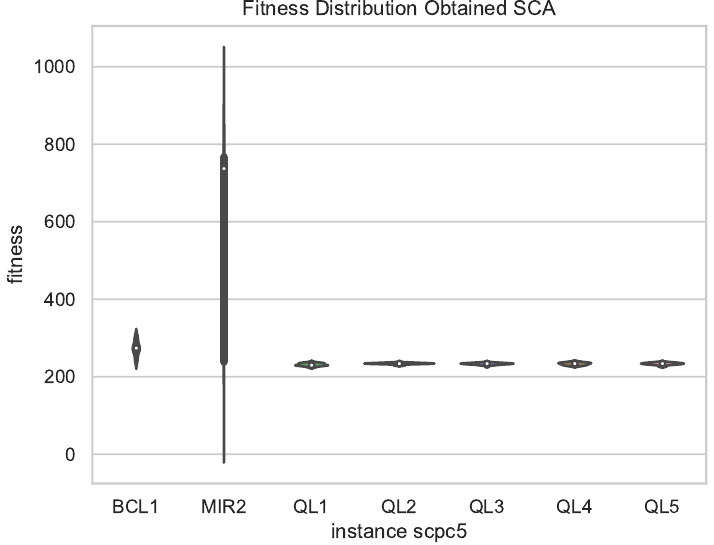
Figure 6. SCA Violin chart of instance c5.